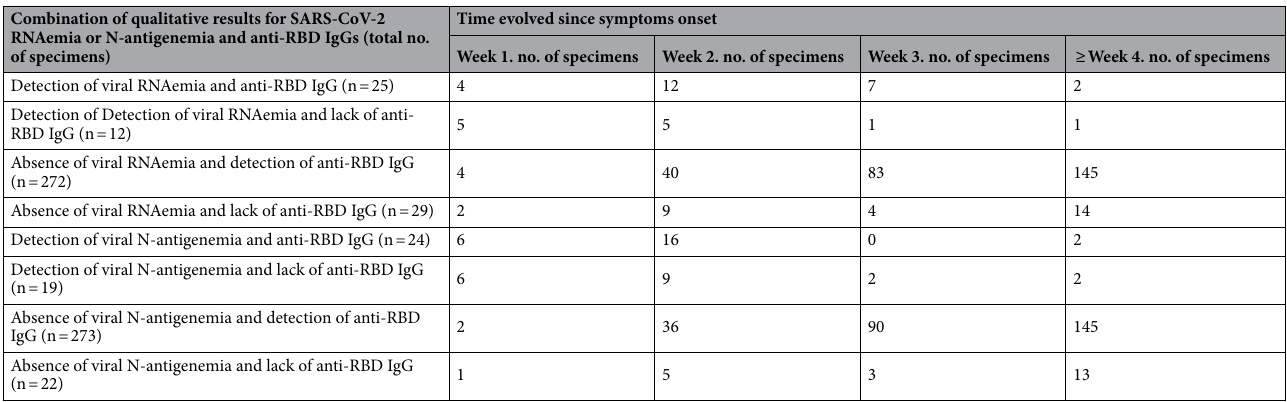
Table 2. Detection of SARS-CoV-2 RNAemia, N-antigenemia and anti-RBD IgG stratified by time since COVID-19 symptoms onset in critically ill patients. RBD receptor binding domain.